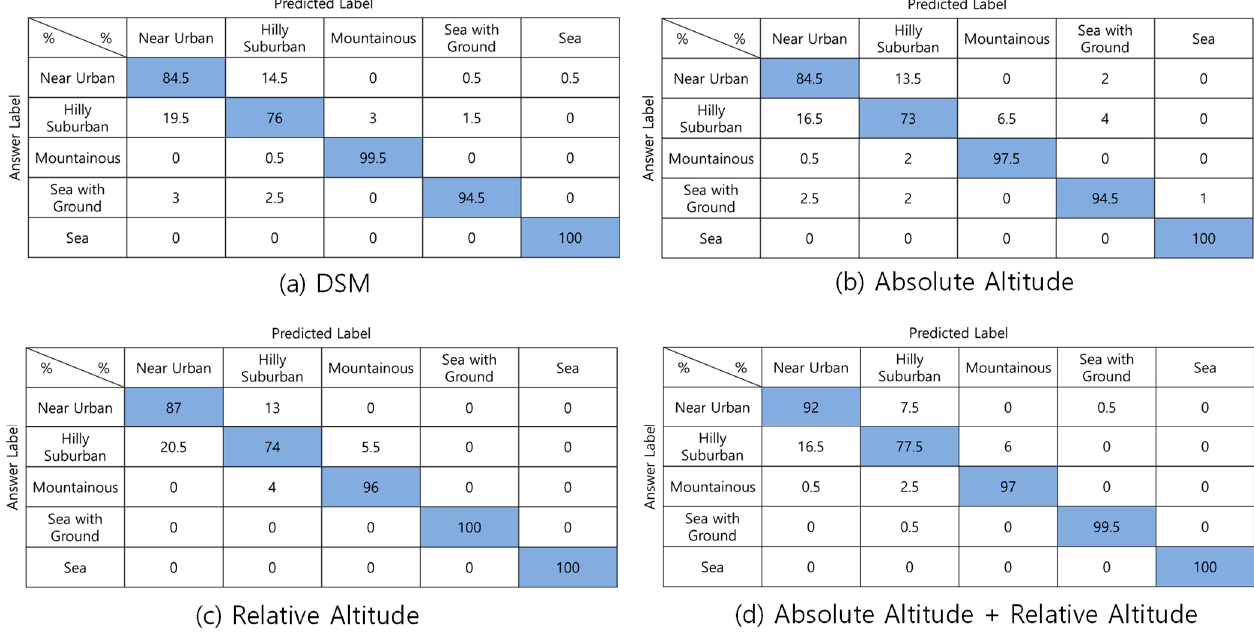
Figure 8. Confusion matrixes of CNN-based one-step classification according to the input features.